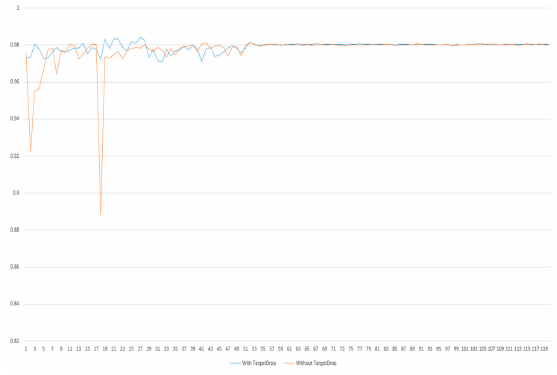
Figure 8. Ablation experiment results of